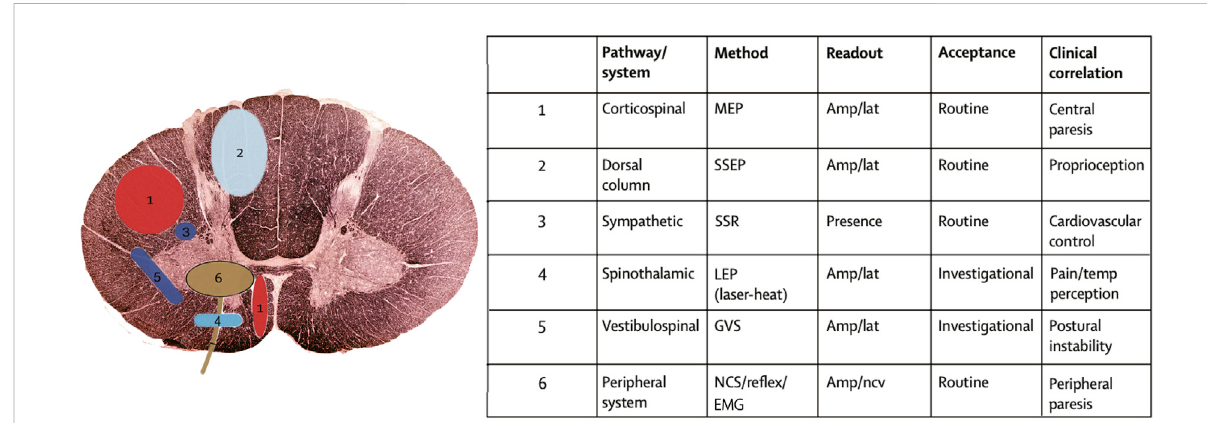
FIGURE 2 Neurophysiological techniques to study the function of speci fi c spinal tracts and of the peripheral nervous system (adapted from (Dietz and Curt, 2006)). The clinical neurologicalexamination can be complementedby electrophysiological recordings to obtain quanti fi able measures about theaffectionofdifferentspinalpathways.Thelocationofthespinalpathwaysoutlinedinthetablearenumericallyassignedintheschematicdiagram. MEP = motor evoked potentials; SSEP = somatosensory evoked potentials; SSR = sympathetic skin response; LEP = laser evoked potentials; GVS = galvanic vestibular stimulation; NCS = nerve conduction study; EMG = electromyography; AMP = amplitude; LAT = latency; NCV = nerve conduction